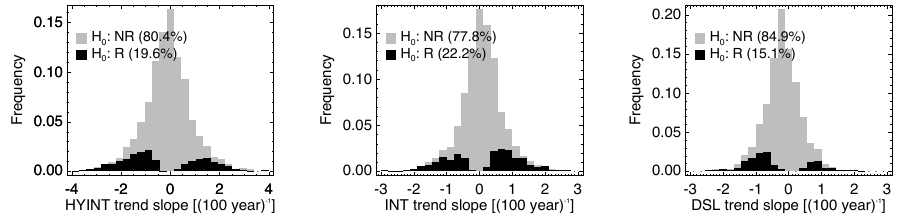
Figure 10. Histograms of the HY-INT ( left ), INT ( center ), and DSL ( right ) trend slopes of the fourth sensitivity rain gauge dataset. Non-significant trends in grey and significant trends in black. Results are similar for other datasets.